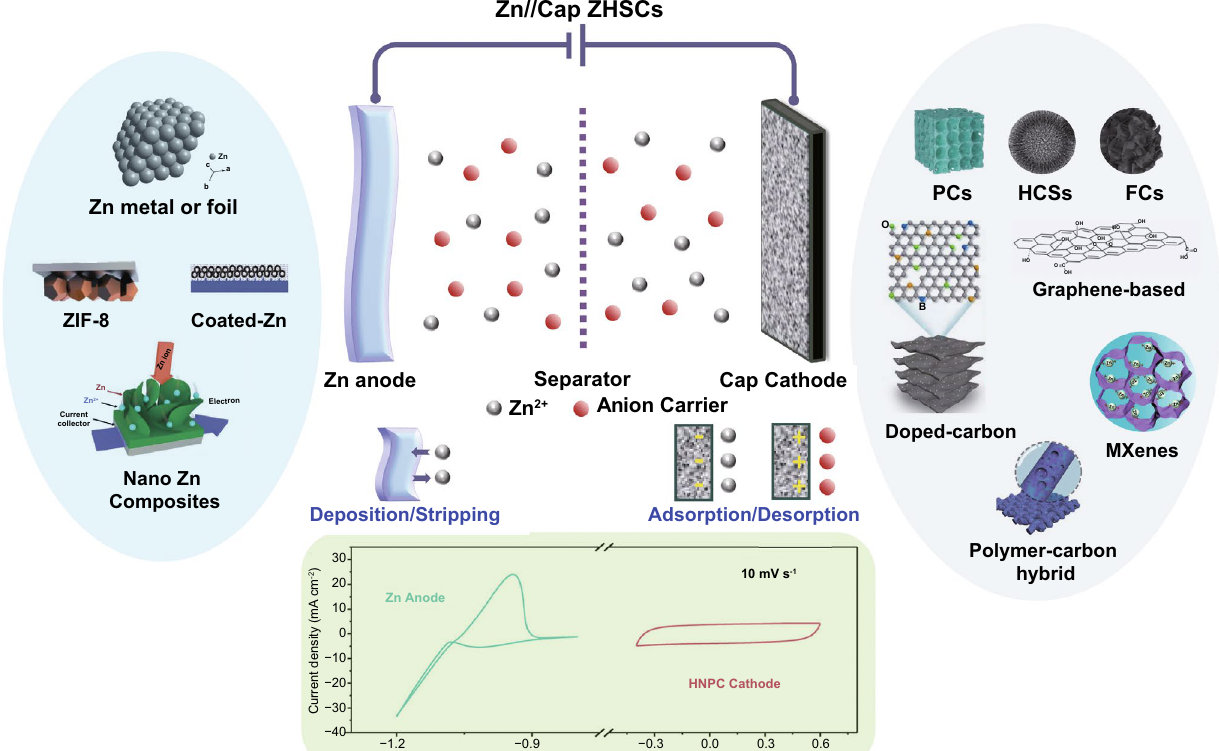
Fig. 1 Schematic illustration (Zn anodes, Cap cathodes, energy storage mechanisms and CV behaviors) of Zn//Cap